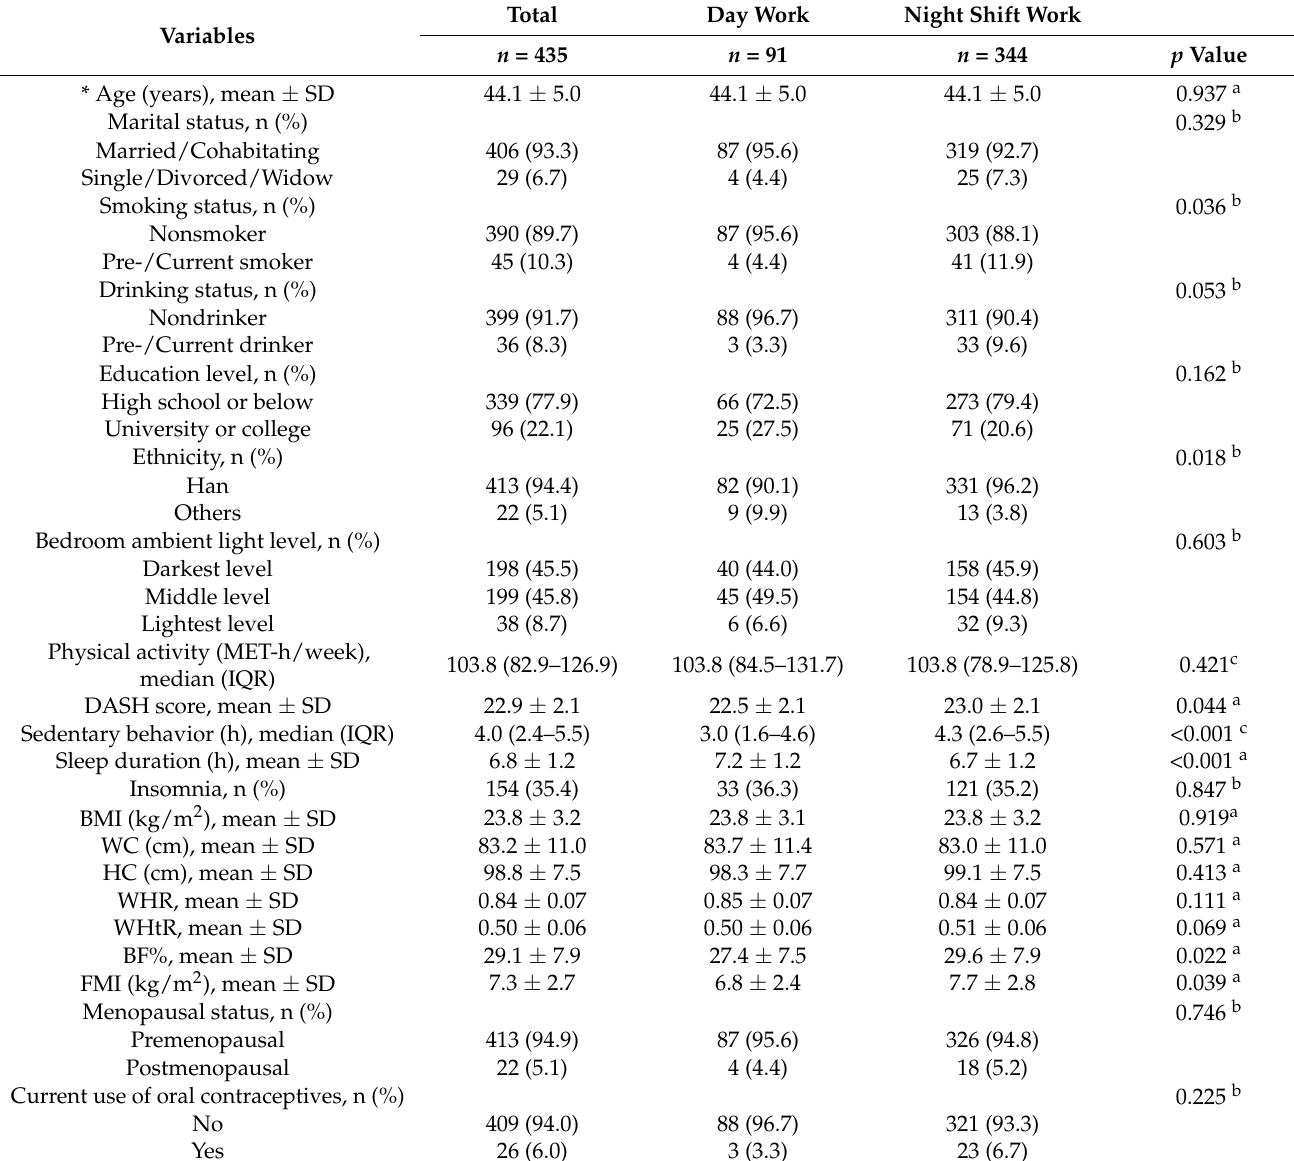
Table 1. The general characteristics of study participants according to shift